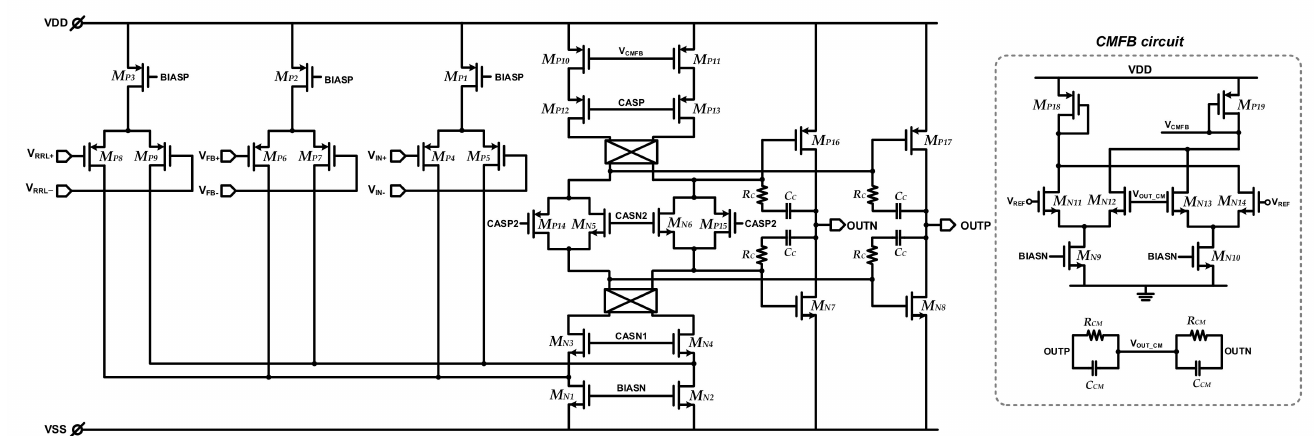
Figure 7. Transistor-level schematic of the proposed